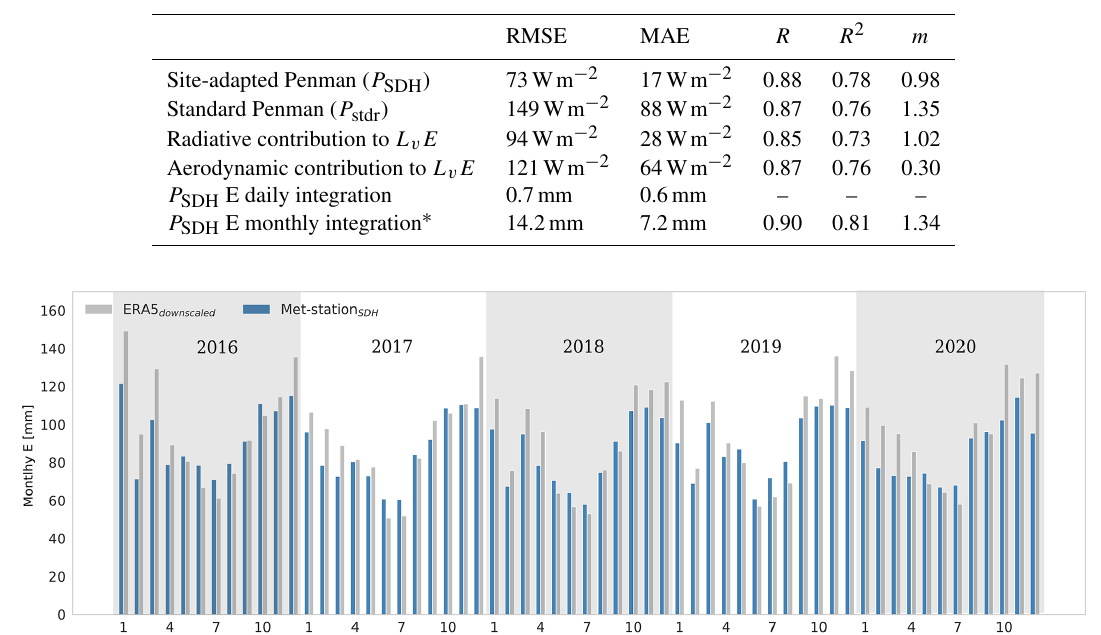
Table 2. Statistical metrics for comparing standard Penman, site-adapted Penman, radiation and aerodynamic contribution for L v E , com- pared to L v E EC water observations. Monthly evaporation integration compares site-adapted evaporation estimates performed using ERA5 and met-station SDH during the period 2016–2020. ∗ Evaporation monthly integration comparison metrics are between P SDH estimates us- ing ERA5 and observation from met-station SDH (Table 1). The m represents the slope of the orthogonal regression between EC water and estimated through the Penman equation.